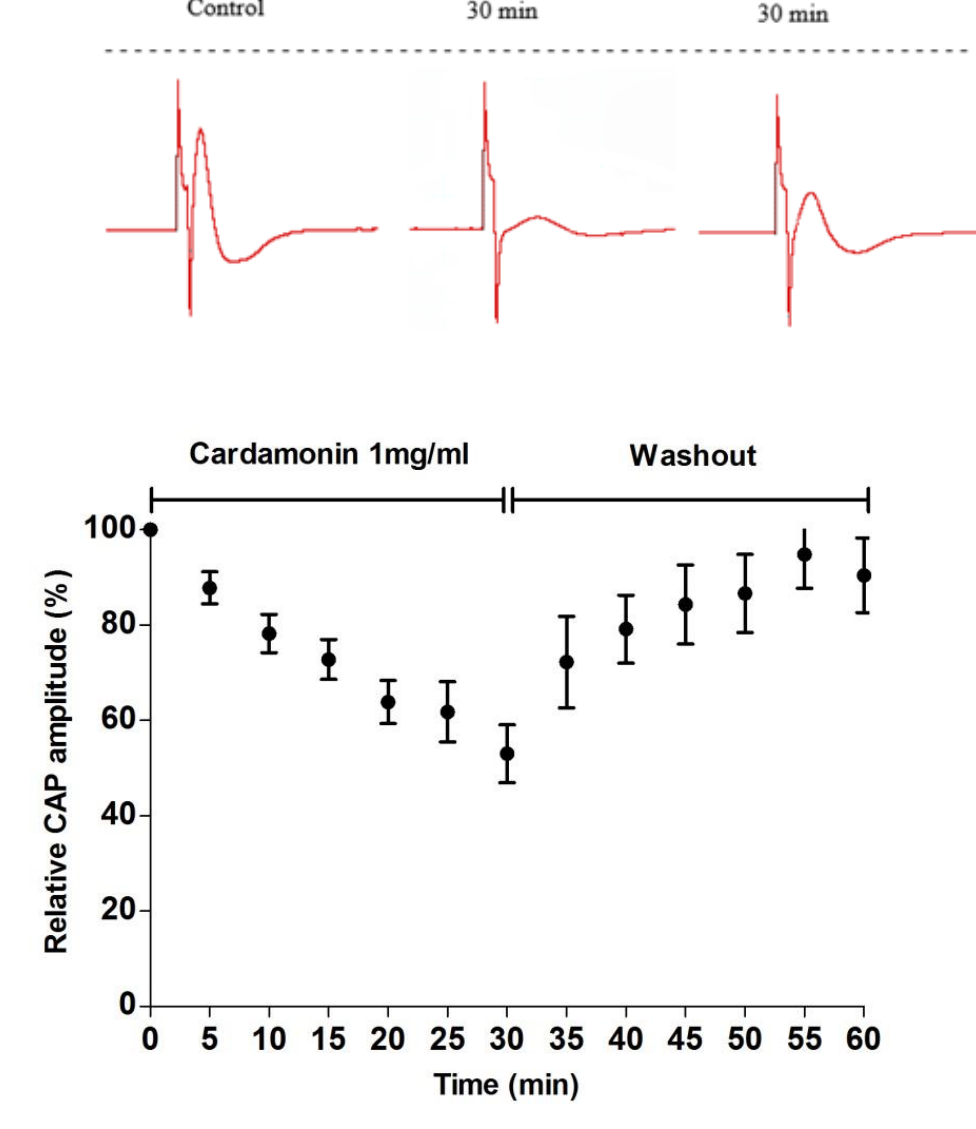
Figure 3A: Upper Panel - Recording of CAPs before treatment at 0 min, 30 min after exposure to cardamonin (1mg/mL) at 30 min after washout. Lower Panel – Average time course of changes in CAP peak amplitudes following exposure to cardamonin (1mg/mL) for 30 min, relative to baseline. Results are shown as mean ± S.E.M., n=6 nerves per